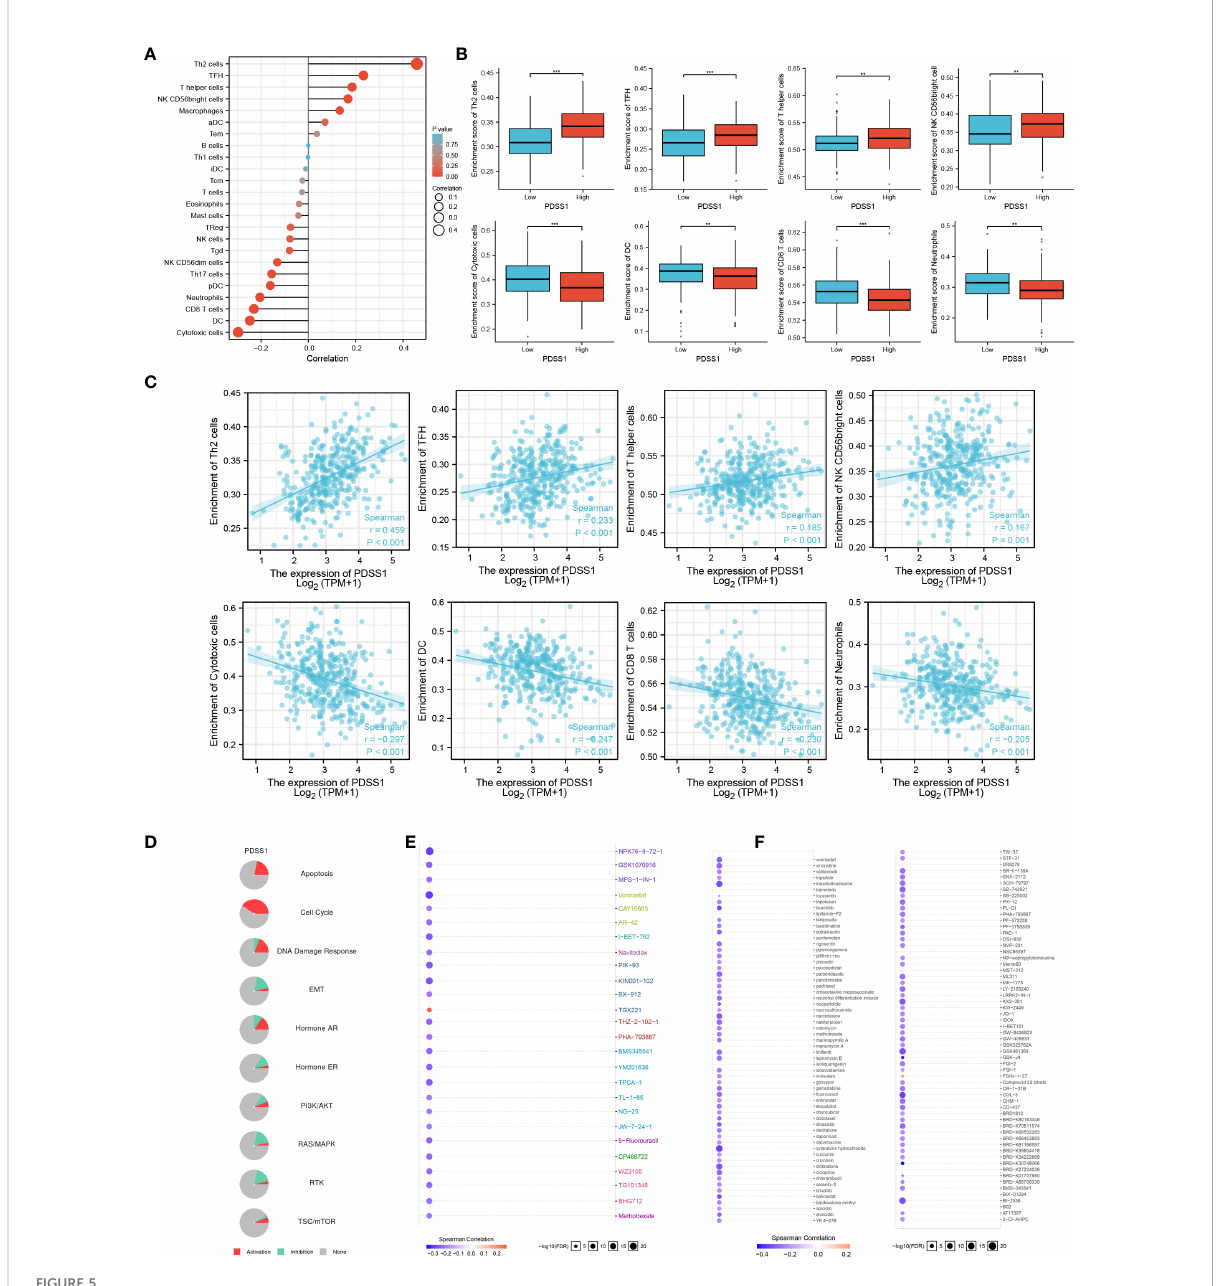
FIGURE 5 The role of PDSS1 in immune in fi ltration, cancer pathways and the drug sensitivity. (A-C) Correlation between expression of PDSS1 and immune cells in fi ltration. (D) PDSS1-related Cancer pathway activity. PDSS1-related drug sensitivity using GDSC (E) and CTRP (F) database. ** p < 0.01, *** p <